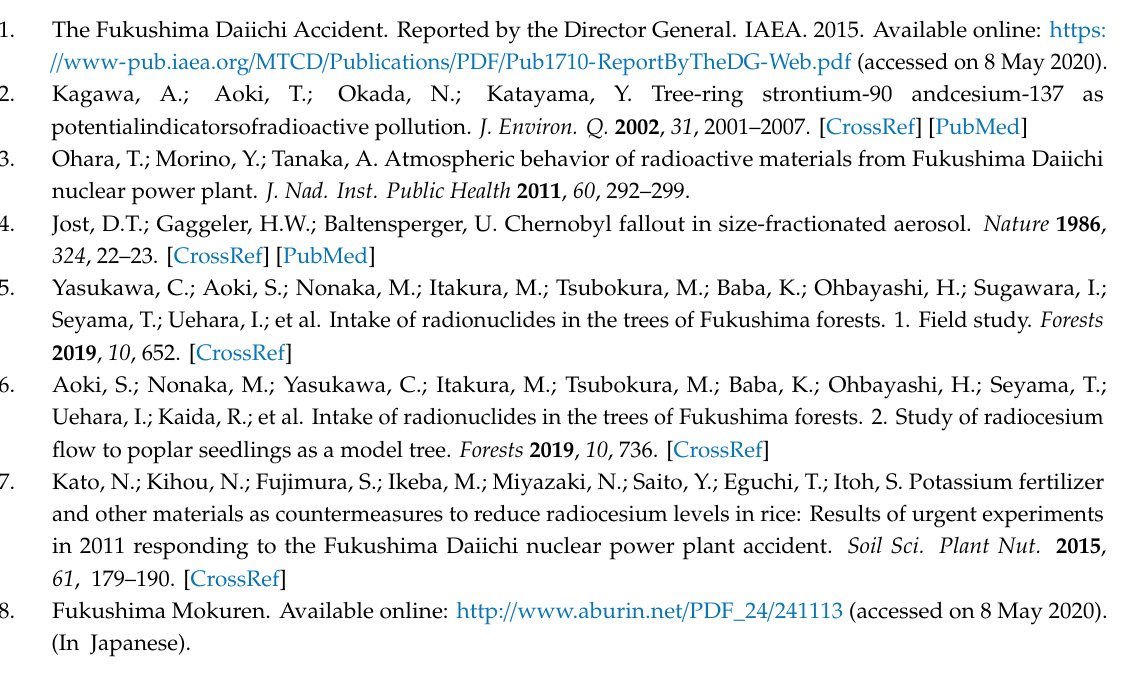
Figure S1: Attempted trials of potassium fertilization into forest trees by foliar spray either by hand (a) or radio-controlled helicopter (b and c) and by direct injection into tree trunks (d, e, and f) in a small forest. A 0.5 to 2 M KCl solution was used for the fertilization., Figure S2: Levels of radioactivity (cpm) determined by NaI (TI) scintillation counter (left) and those of radiation ( µ Sv) using a Geiger counter (right), based on radiocesium content (Bq / kg) in the stem section., Figure S3: Ponding method for Fukushima forest trees. Cutting (a), immersion in the pool of water (b), stems in a pool (c), covered pool (d), vertical drain (e), and horizontal drain (f)., Table S1: Numbers of stems used for ponding